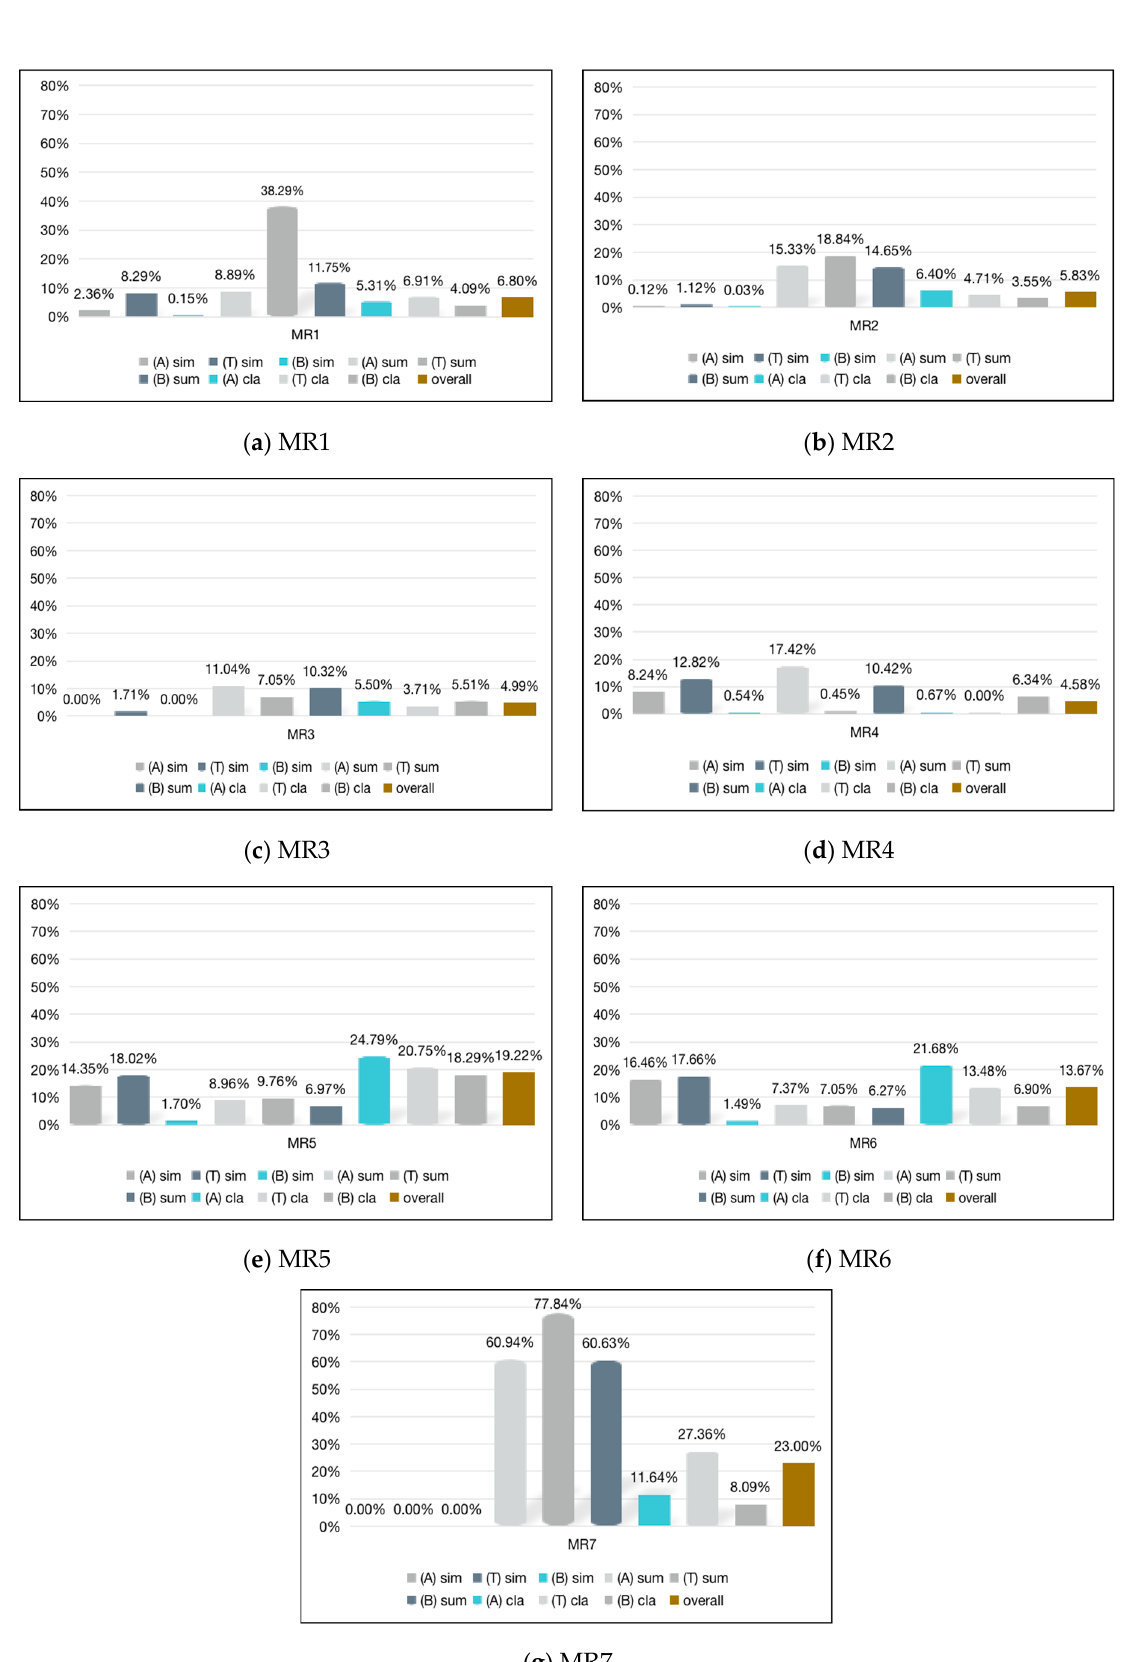
Figure 10. Experimental results of each MR under different systems and tasks.